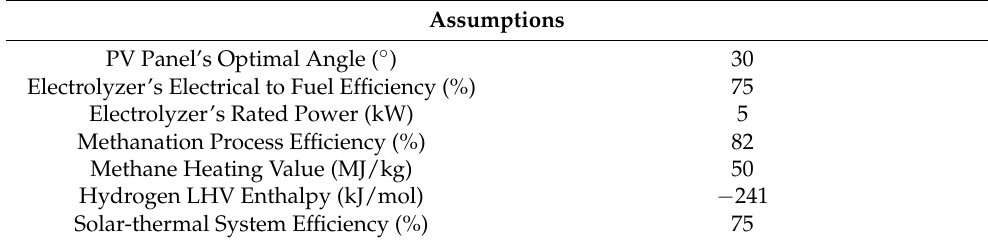
Table 1. Assumptions used in this study for several parameters. Abbreviations: photovoltaic (PV), lower heating value